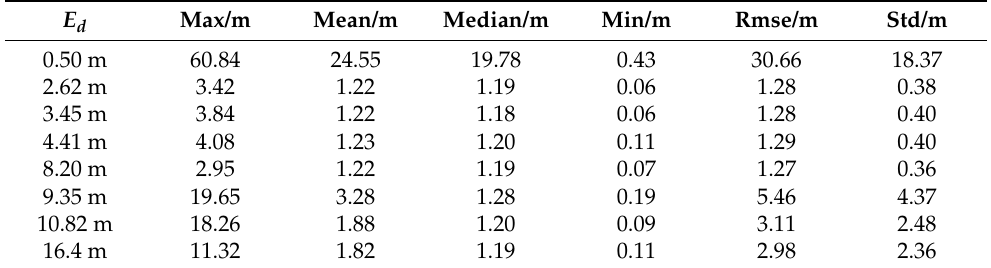
Table 3. Error parameters of the different localization verification thresholds of forwarding spoofing.